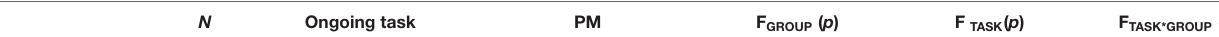
TABLE 1 | Mean accuracy and RT (M ± SD) of LD group and controls group. N Ongoing task PM F GROUP ( p ) F TASK ( p ) F TASK*GROUP ( p